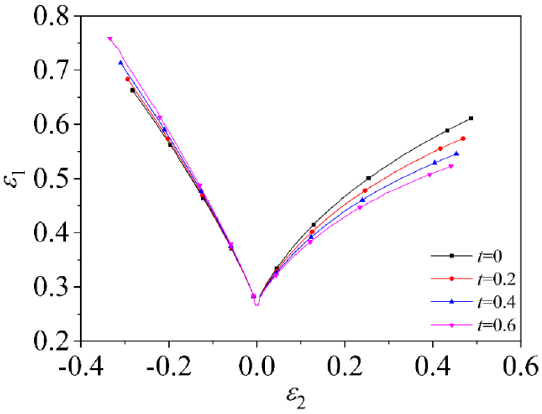
Figure 12. FLD of material TRIP780 based on Mises yield criterion and C-H instability criterion.